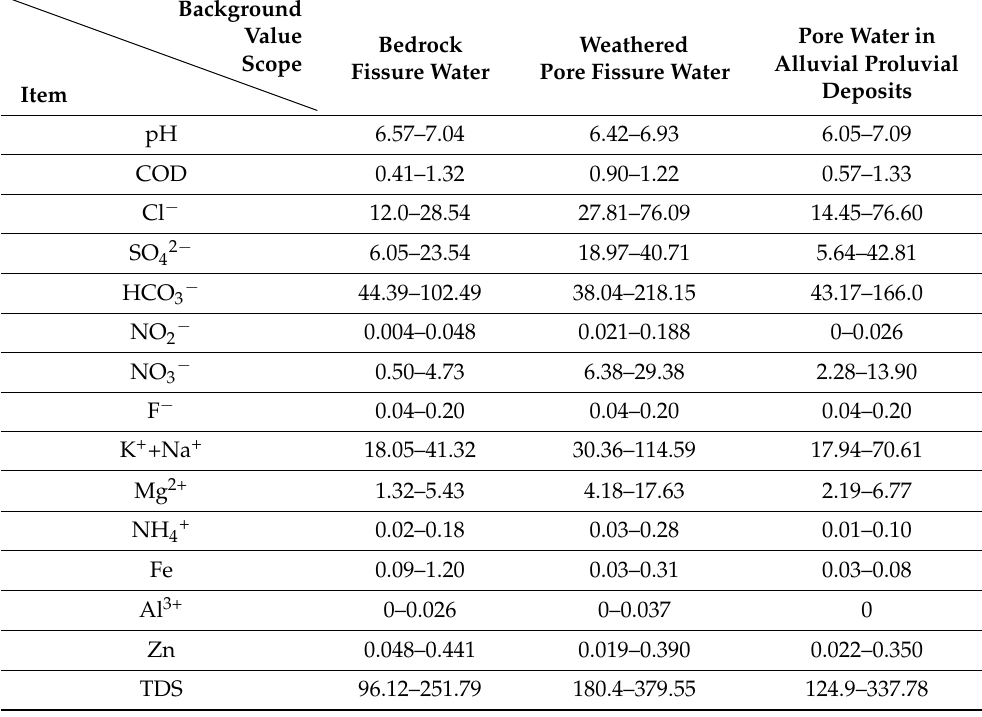
Table 4. Background values of groundwater environment in different water-bearing media in Xiamen.